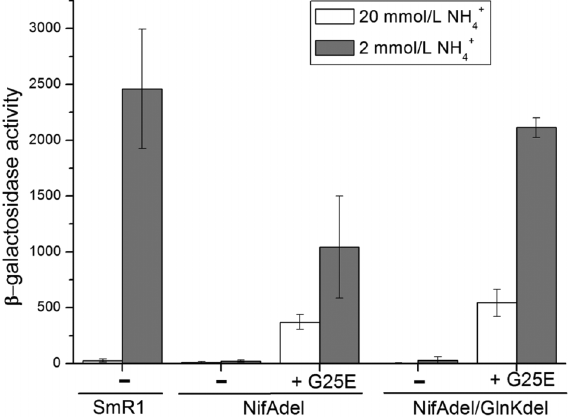
Figure 4. Transcriptional activity of indicated Herbaspirillum seropedicae strains carrying a chromosomal nifH:lacZ fusion. + G25E indicates cells carrying a pLAFR3.18-based plasmid expressing the G25E NifA mutant; ( – ) indicates absence of plasmid. Cells were grown in NFbHP medium supplemented with 10 mM NH 4 Cl under aerobic conditions at 30°C. Cells were then centrifuged (1700 g for 2 min), resuspended in NFbHP (nitrogen- free) medium, and de-repressed for 7 h under 1.5% oxygen. b -galactosidase was determined as described. Data are reported as the mean±SD of at least 3 independent experiments. b -galactosidase activity is reported as Miller